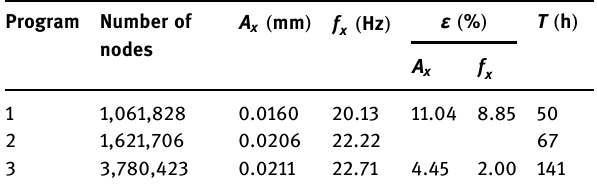
Table 2: Calculation results of grid independence